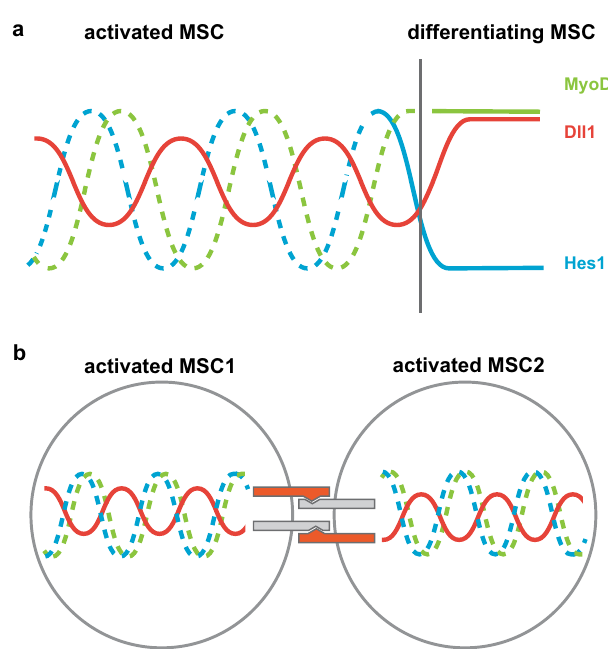
Fig. 9 Oscillatory expression of Dll1, Hes1, and MyoD controls self- renewal and the timing of differentiation. a Dll1, Hes1, and MyoD are dynamically expressed in activated muscle stem cells (left). Hes1 is no longer expressed, and Dll1 and MyoD expression are sustained when muscle stem cells differentiate (right). b In contacting cells that are activated, the periodic Dll1 input into the Notch signaling cascade needs to be coordinated between the two cells in order to allow stable oscillations. MSC muscle stem